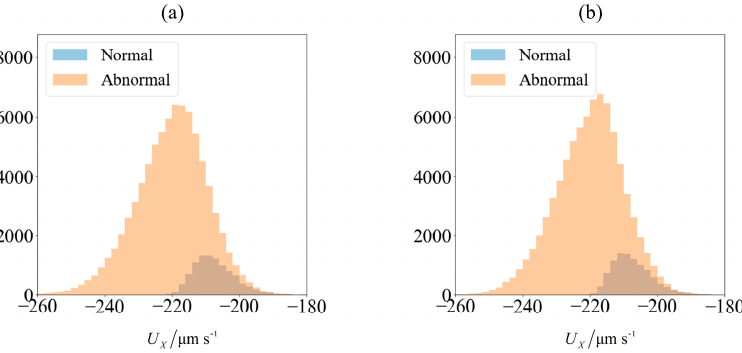
Figure 4. Velocity of spermatozoa in the test set of 90,000 samples ( a ) computed using SBT computation and ( b ) obtained from predictions made using an ensemble of supervised learning trained on 10,000 samples. The blue and orange region represents the number of morphologically normal and abnormal cells, respectively. The sperm cells are subjected to C 0 = − 1 mN/mm 3 .